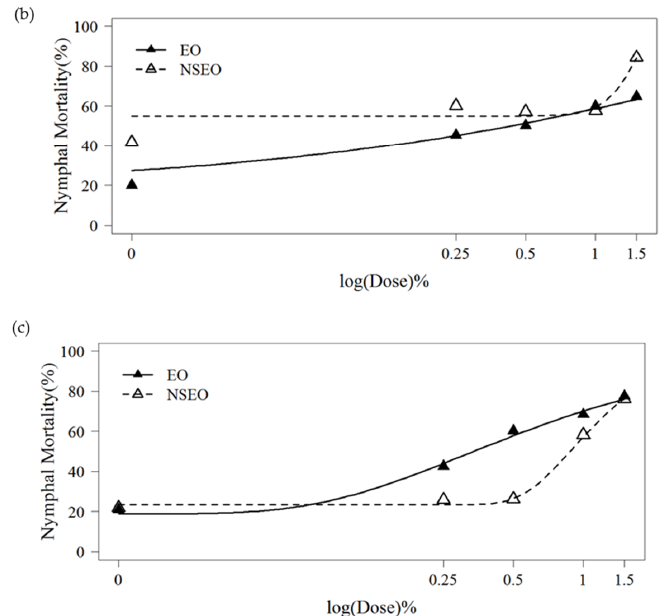
Figure 3. Mortality of 2nd-instar nymphs of B. tabaci after application of essential oil in the free (EO) and nanoencapsulated (NSEO) forms at different concentrations for experiment 1 ( a ), experiment 2 ( b ), experiment 3 ( c ). Curves were adjusted according to 3-parameter generalized Gompertz model for binomial response data ( a ) and Weibull ( b , c